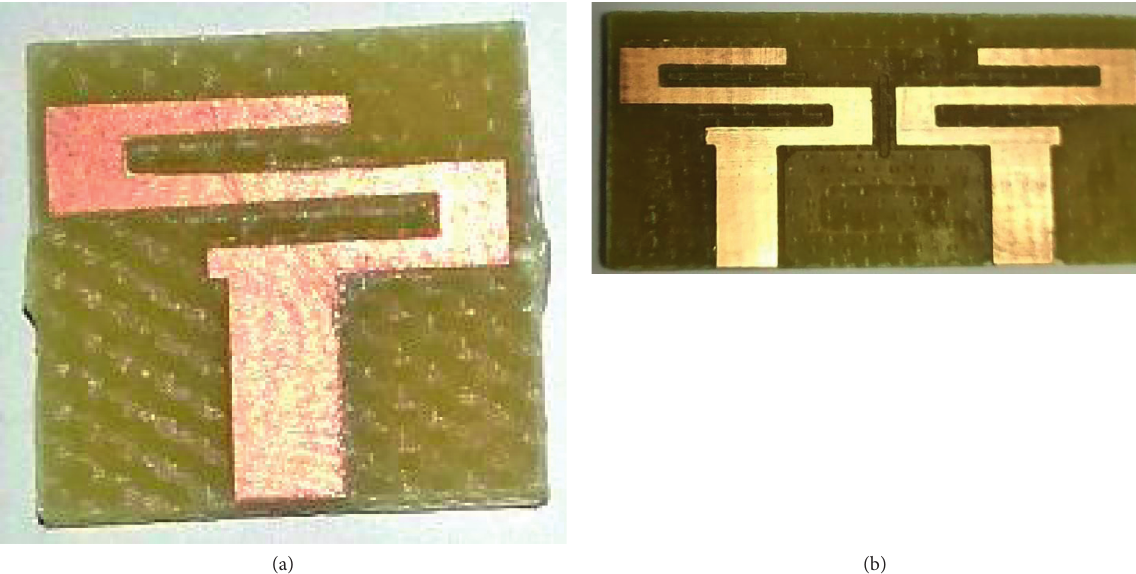
Figure 9: Photograph of the prototypes: (a) single antenna and (b) MIMO